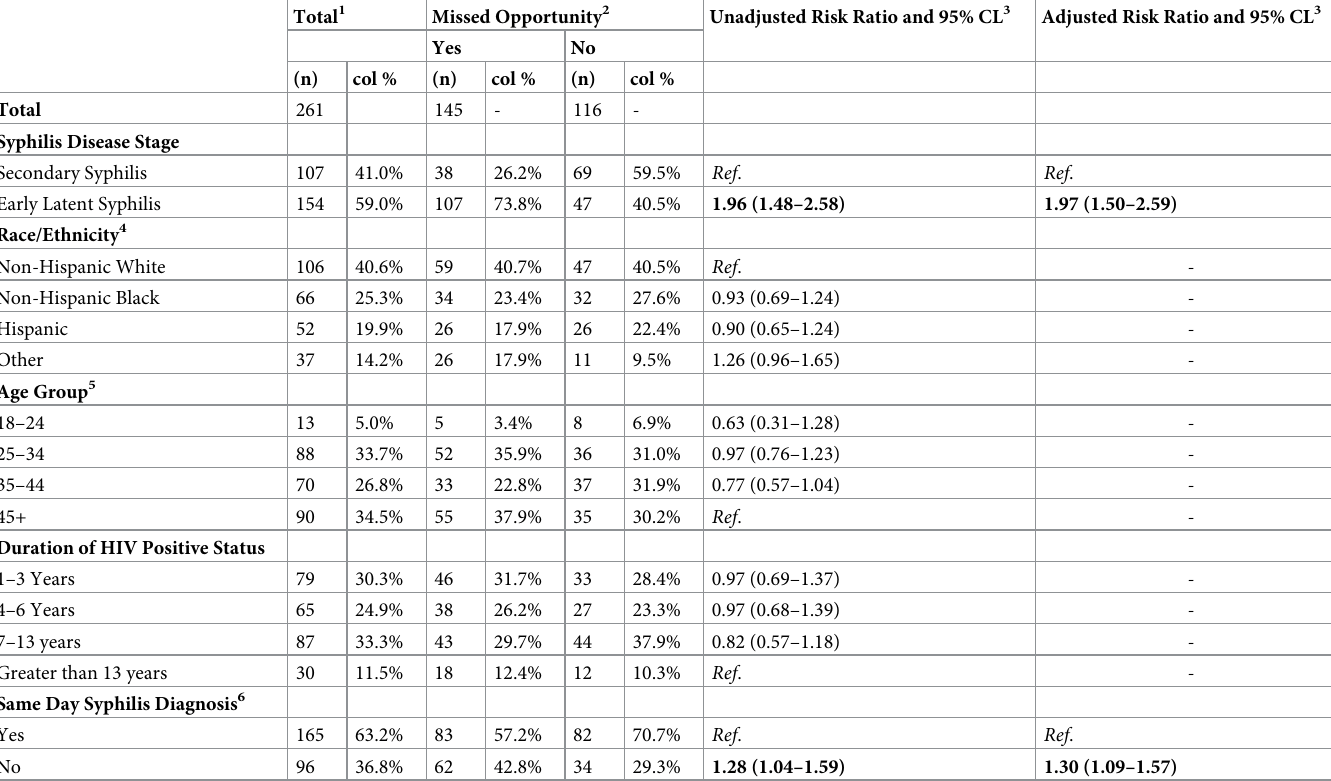
Table 2. Missed opportunities for earlier syphilis diagnosis cohort of adult males with a history of male-to-male sexual contact living with diagnosed HIV: New York state excluding New York CIty,